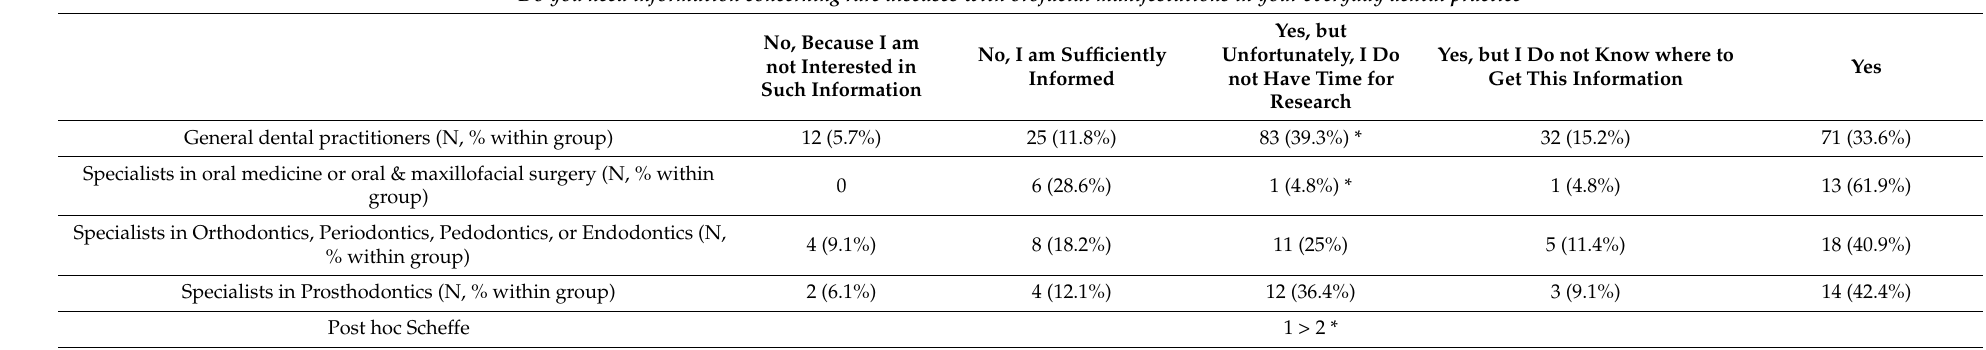
Table 7. Tables providing distribution of answers related to sources of knowledge about rare diseases domain. Some depicts post-hoc Scheffe comparisons, while the rest do not contain such comparisons as the results were not different in a statistically significant